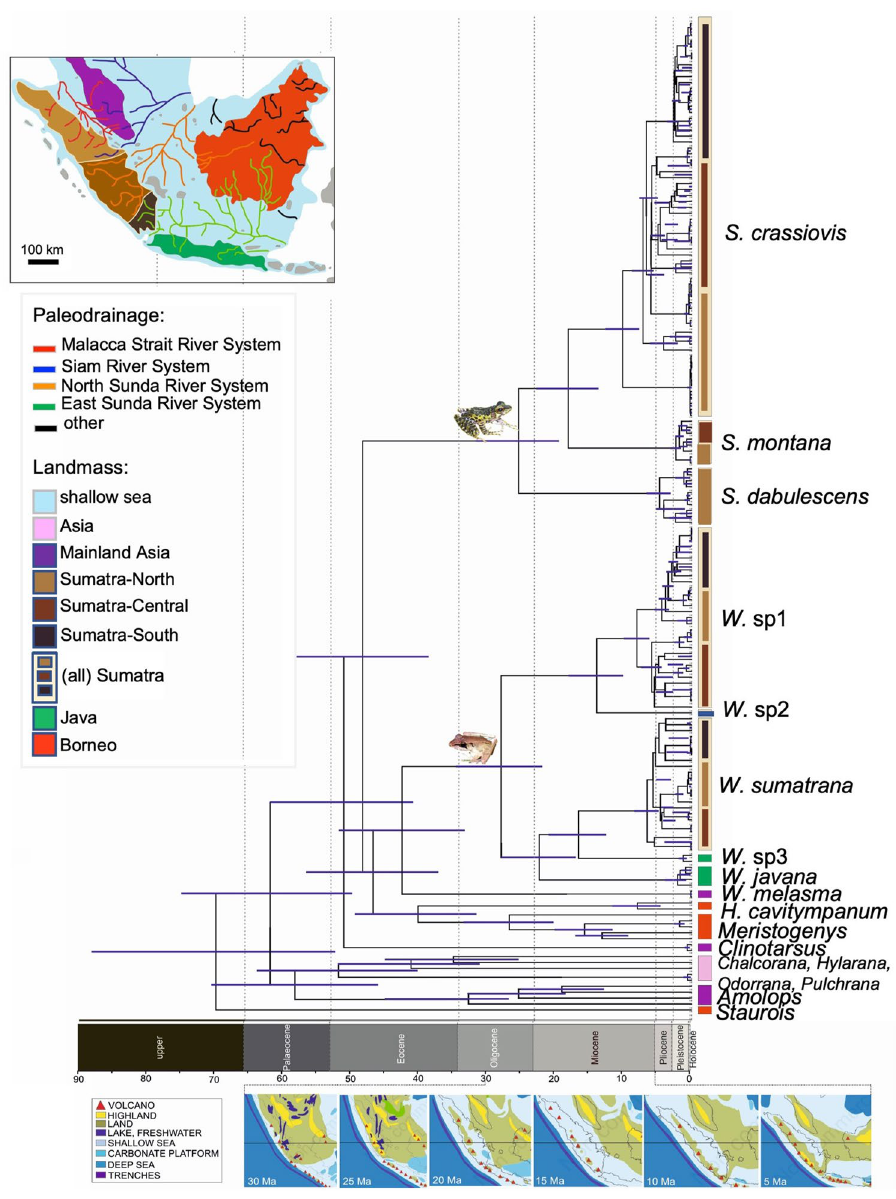
Figure 3. Divergence time estimates of Sumaterana and Wijayarana from Sumatra and Java (photos by UA). Colors and labels are explained in the legend in the bottom left box (sensu Hall 14 ). Ancestral areas (circles at nodes) and geographic distributions (squares at tips) are color-coded according to the Pleistocene river systems in Sundaland (modified from Voris 19